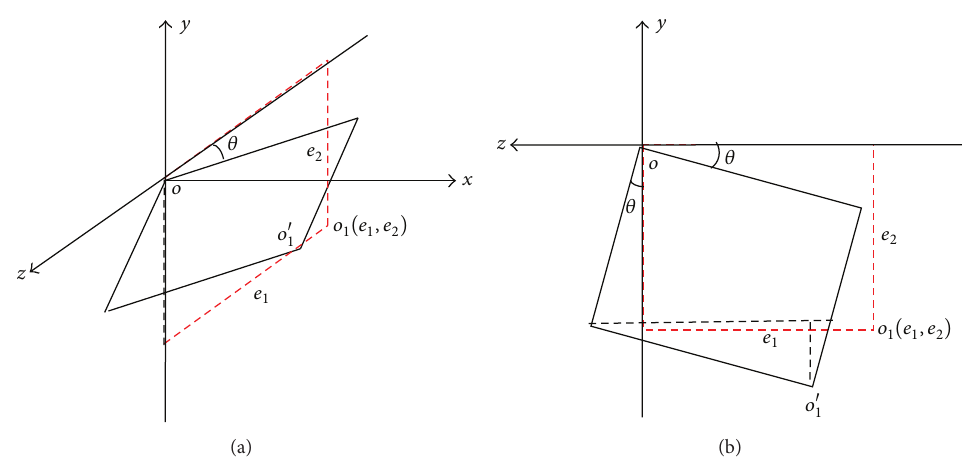
Figure 2: Coordinate system: (--) original location, (—) location after